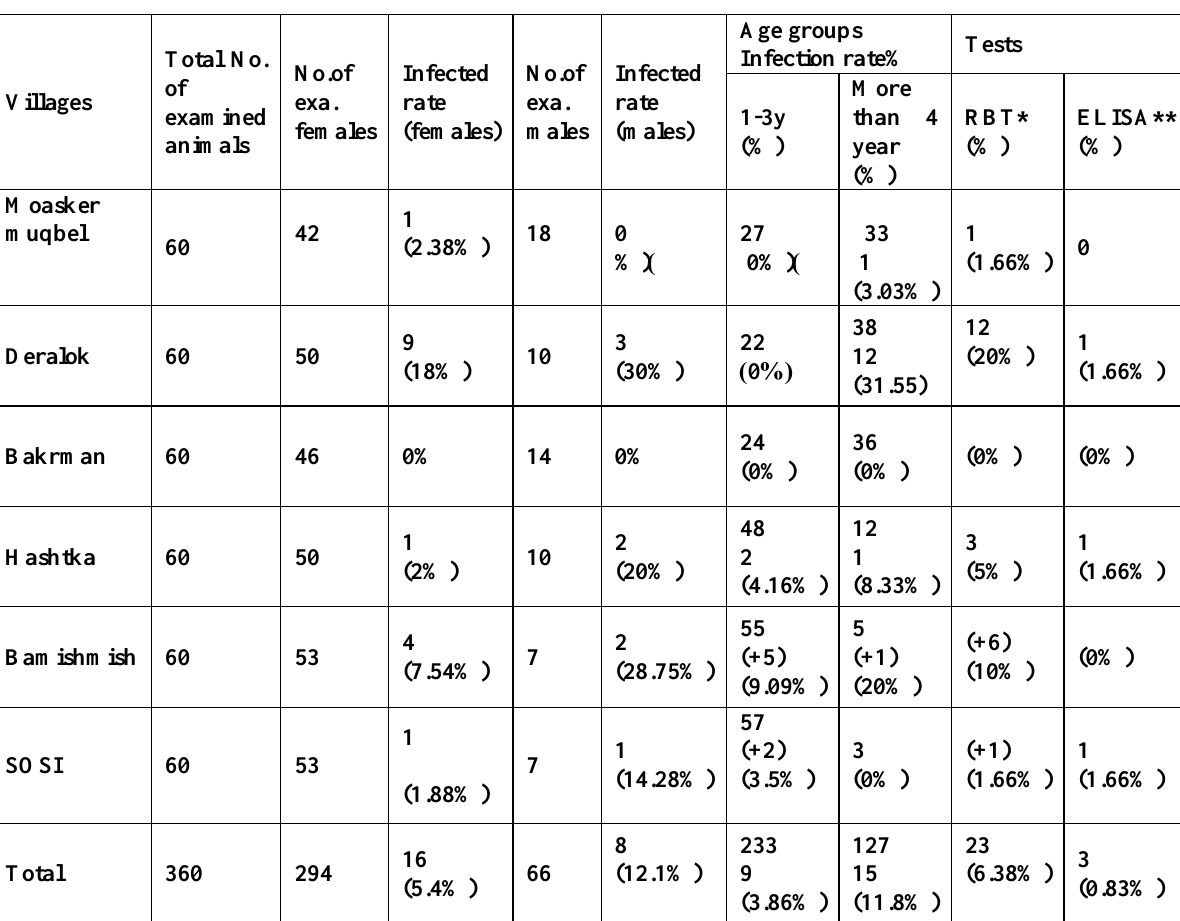
Table 1: Seroprevalence of brucellosis in cattle of different areas around